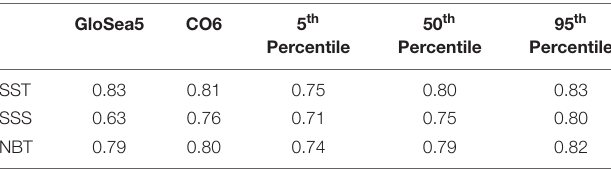
TABLE 4 | The spatial correlation of the GloSea5 and CO6 2011-2011 anomaly with CMEMS 2011-2010 anomaly over the shelf